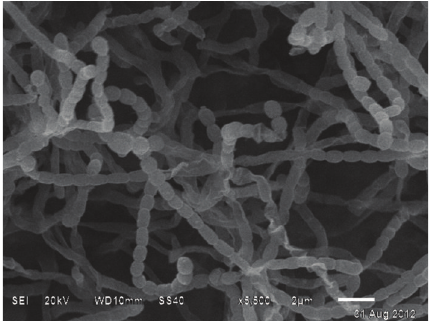
Figure 3: Scanning electron micrograph of BTSS 1001, a marine actinomycete grown on ISP 2 media for 3